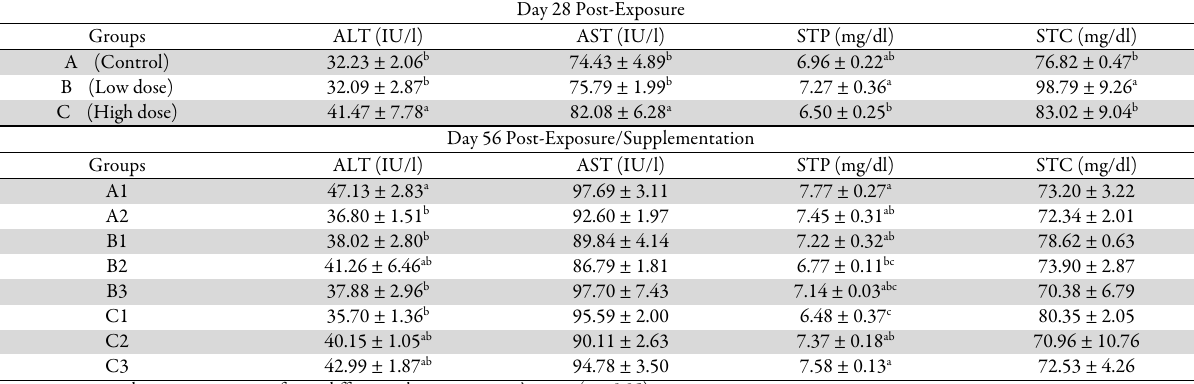
Table 2. Effects of Vitamin E supplementation on serum biochemistry in male rats with crude oil-induced